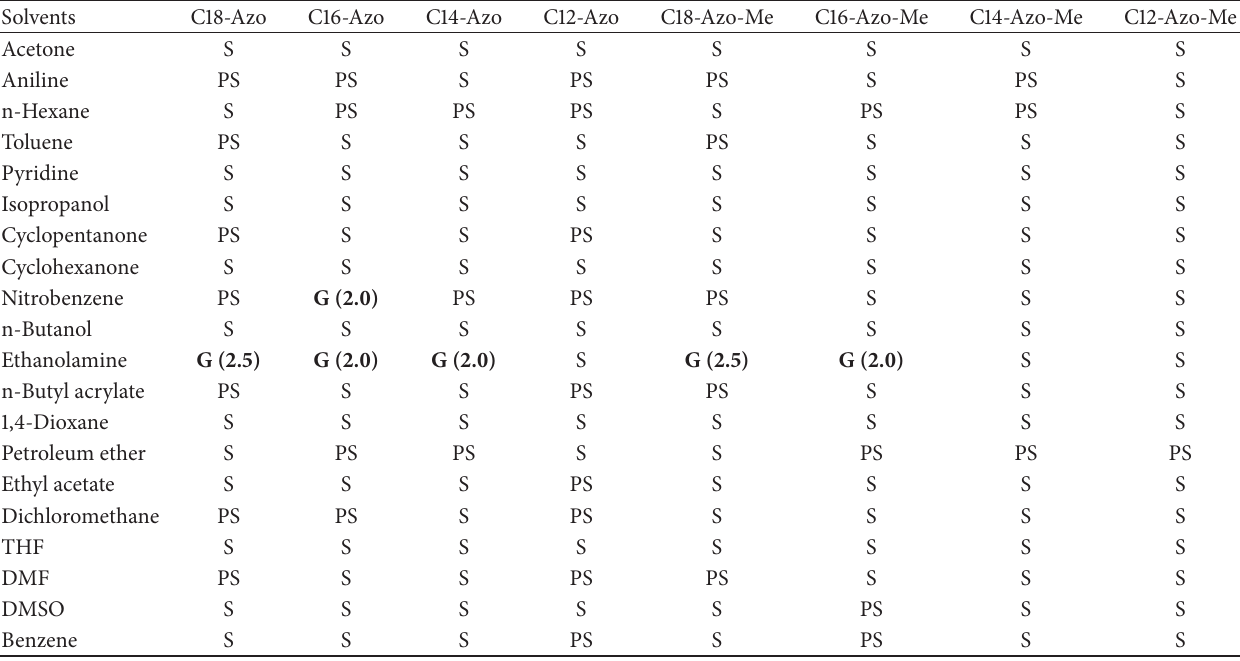
Table 1: Gelation behaviors of these binary